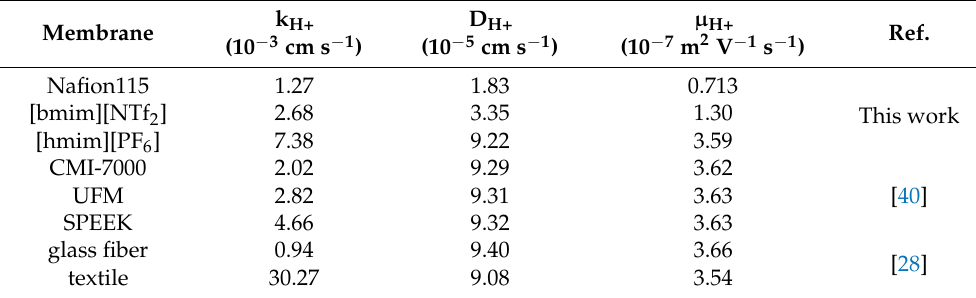
Table 2. Proton mass transfer coefficient, diffusion coefficient, and electric mobility of various